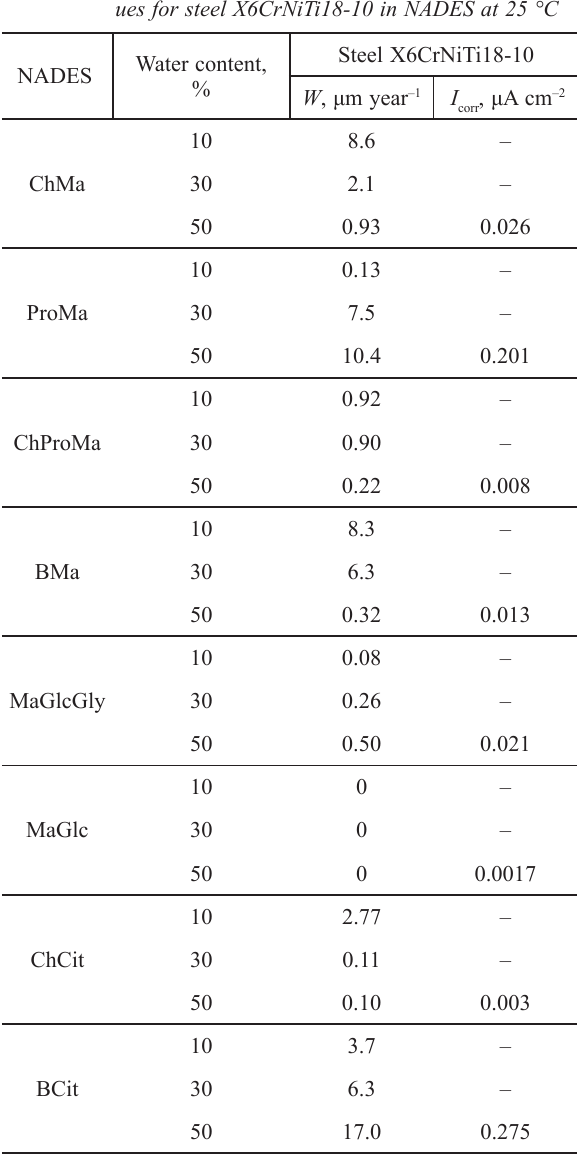
Table 4 – Corrosion rate data (W) obtained from weight loss measurements and corrosion current densities